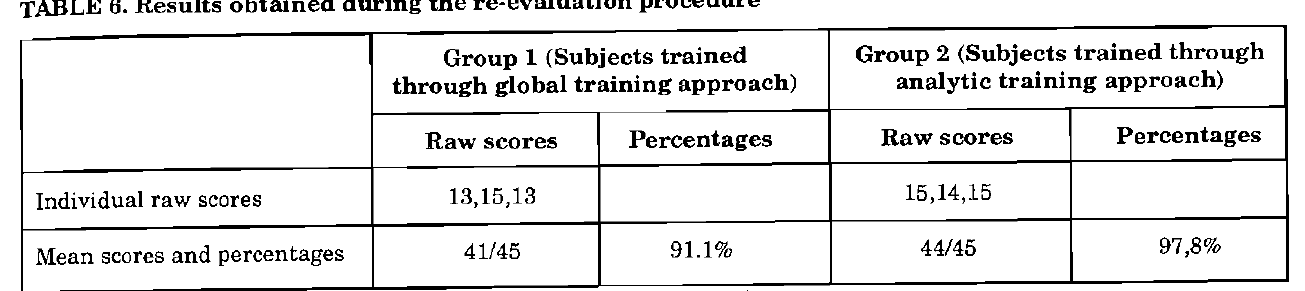
TABLE 7. An error analysis of the results obtained during the training